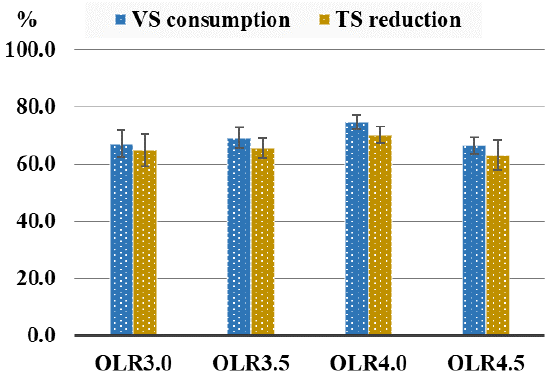
Figure 6. TS reduction and VS consumption.